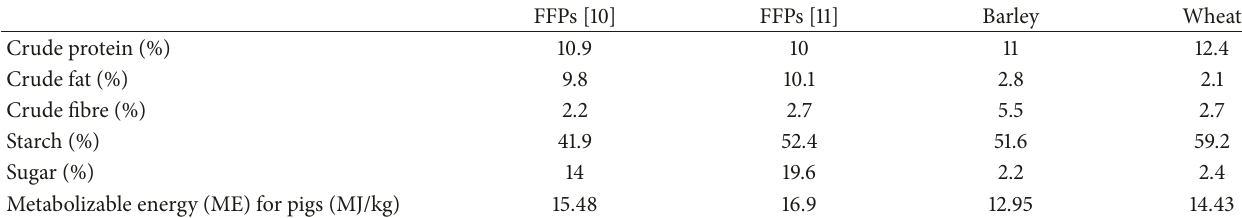
Table 1: Nutrient composition of FFPs evaluated in two different studies, barley and